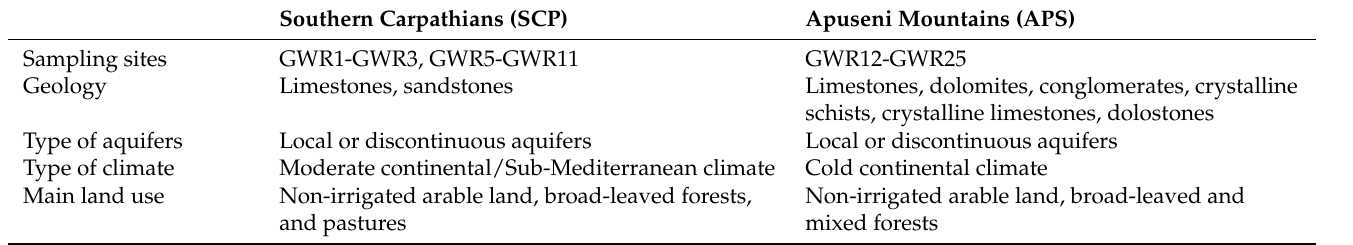
Figure 1. Springs (GWR) located in the Southern Carpathians (SCP) and the Apuseni Mountains (APS) karst areas. Table 1. Characteristics of the study